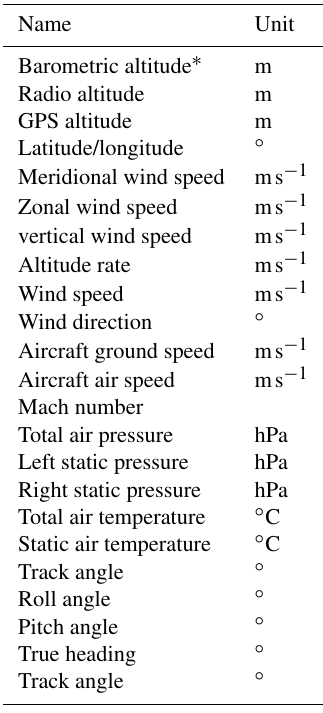
Table 1. Parameters provided by the A340/A330 aircraft system.